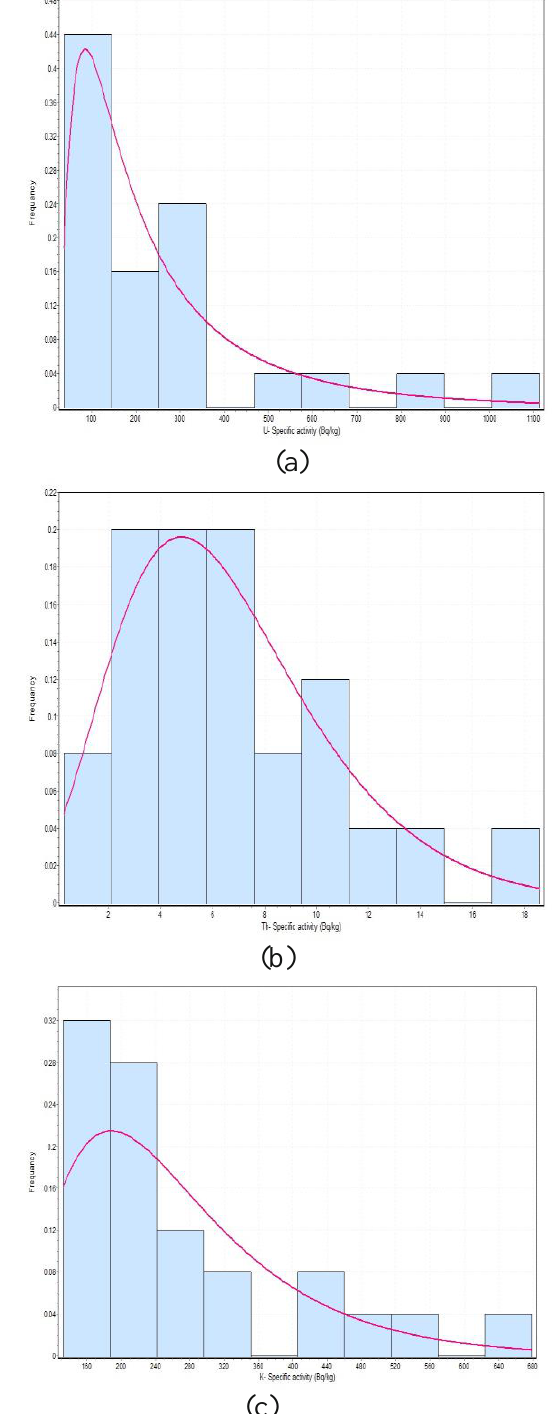
Fig.2: Frequency distribution of, (a) 232 U- specific activity, (b) 232 Th- specific activity, (c) 40 K- specific